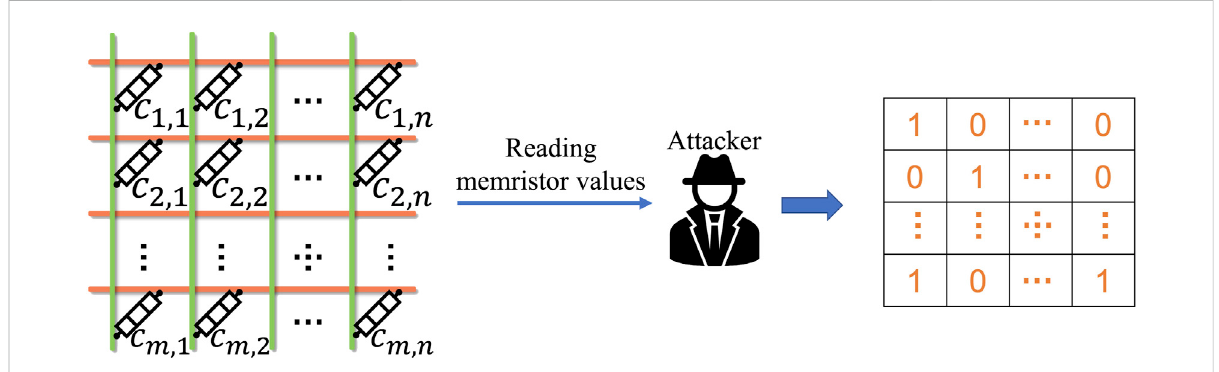
FIGURE 5 WB threat model: the attacker can read the memristor values to reverse-engineer the corresponding NN matrices stored in the memristor